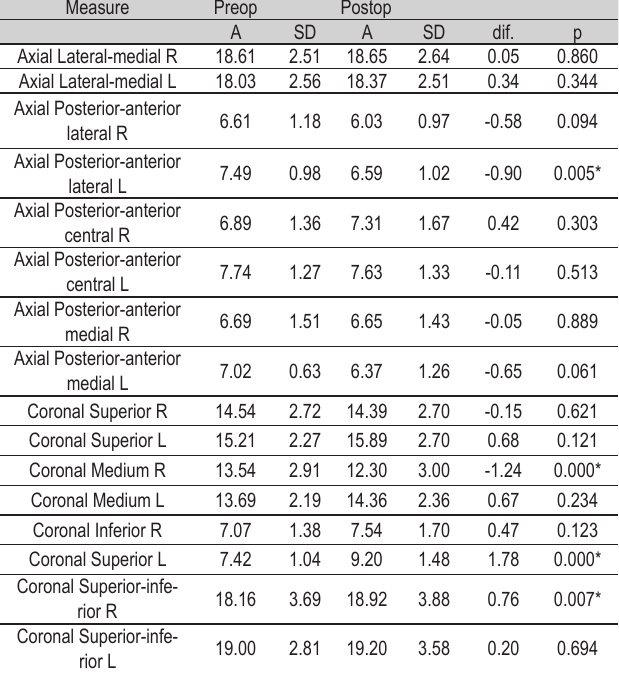
Table 2 - Average (A), standard deviation (SD), difference between preoperative (Preop) and postoperative (Postop) averages (dif), paired t-test result (p), when the right and left condyles were considered separate (*p<0.05). R = right. L =